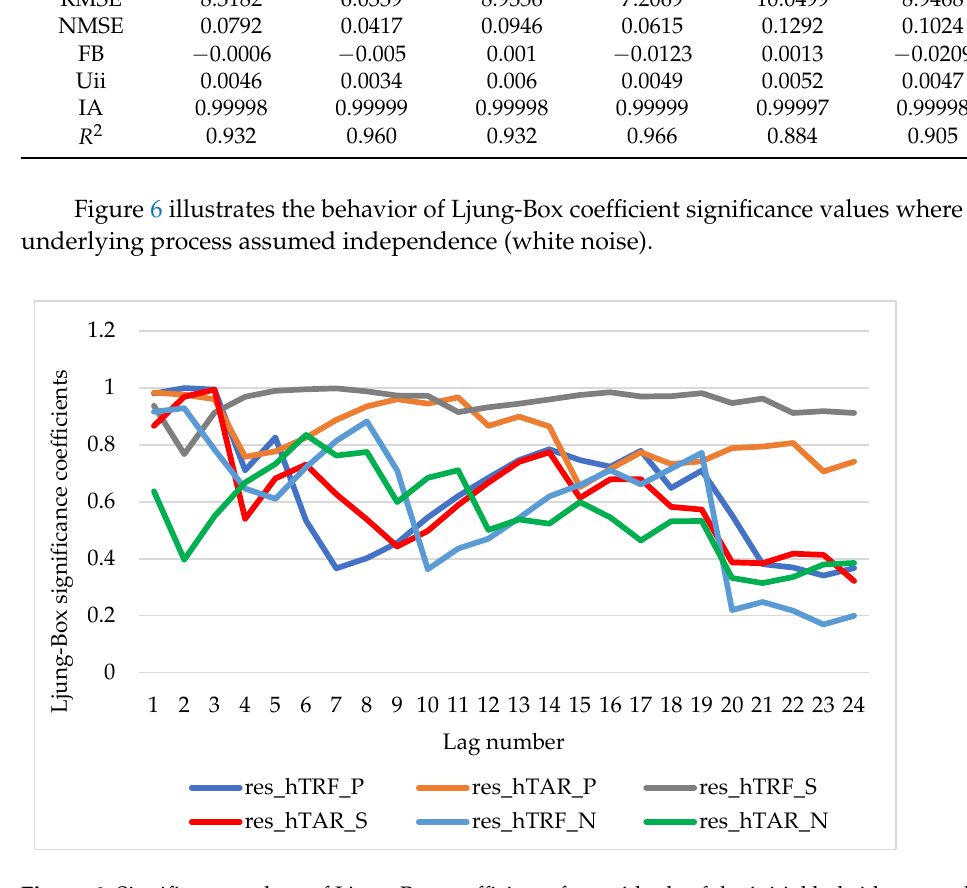
Table 5. Performance statistics of the hybrid RF-ARIMA/TF and ARC_ARIMA/TF initial models.